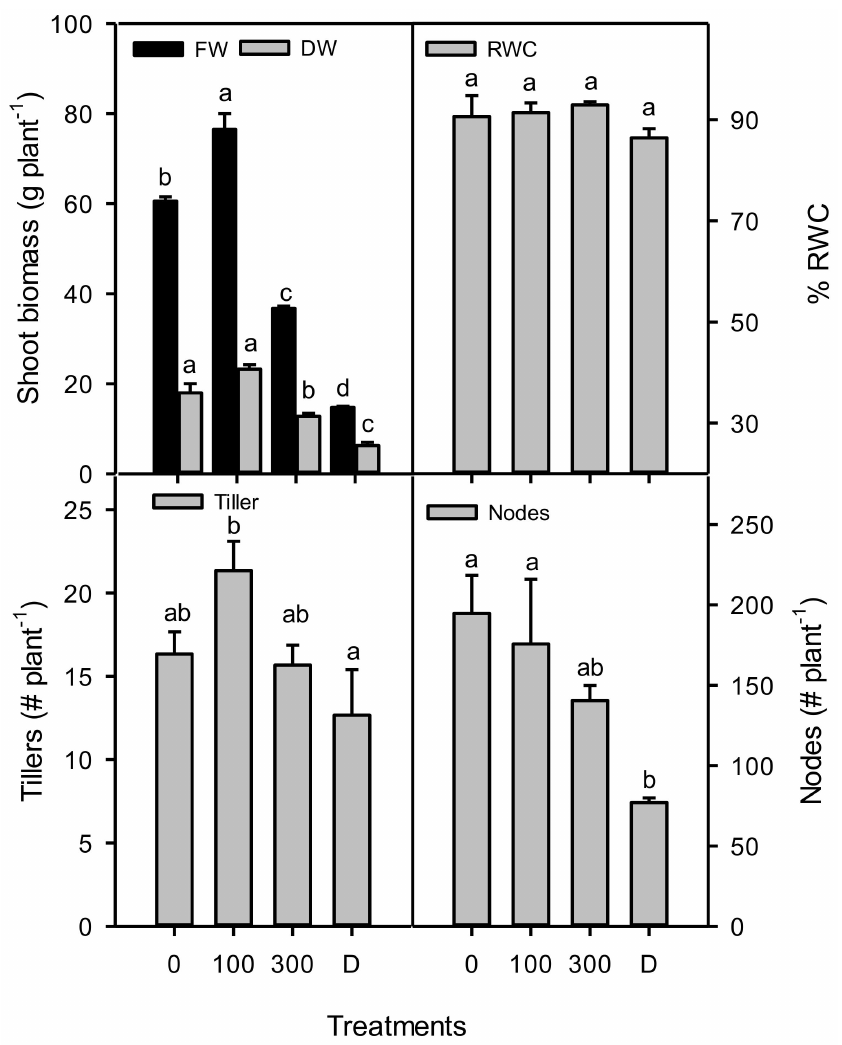
Figure 1. Plant fresh and dry shoot biomass, number of tillers, number of nodes of Phragmites karka grown at 0, 100, and 300 mM NaCl and drought. Different lower-case letters indicate significant differences due to salt treatments, according to Bonferroni’s test ( p <